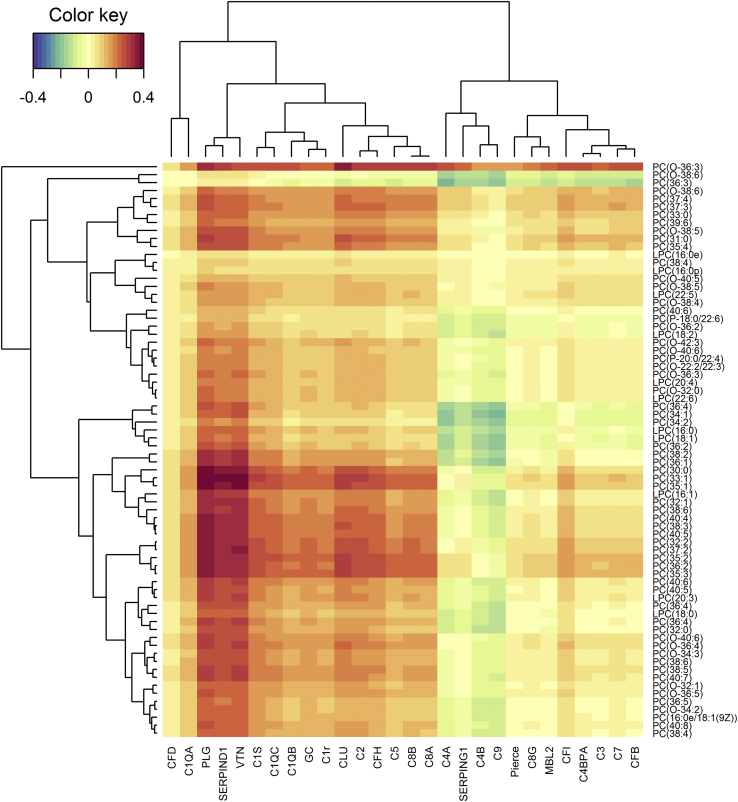
Heatmap analysis performed by using regularized canonical correlations analysis showing the relation between proteomic and lipidomic datasets. For proteomic data, the gene names are displayed. Correlation strengths are indicated by the color key.